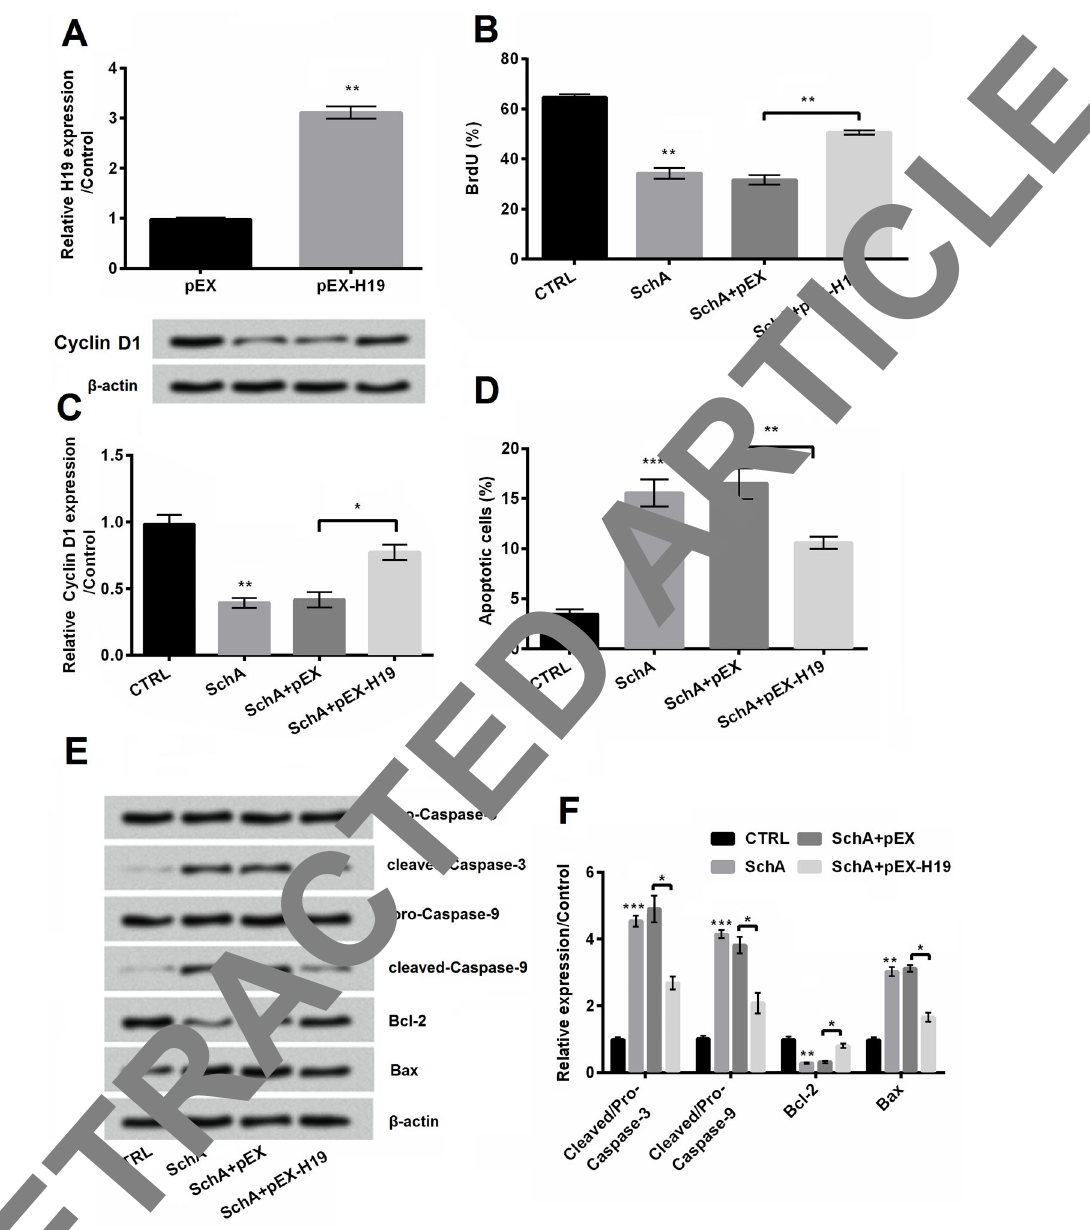
Figure 5. Schizandrin A (SchA) decreased cell proliferation and increased cell apoptosis via down-regulation of H19. A , Overexpression of H19 was established through transfection with pEX-H19 in A375 cells. Cell proliferation ( B ) and ( C ) expression and level of cyclin D1 were analyzed via BrdU, western blot, and quantitatively, respectively. D, Cell apoptosis was analyzed by fl ow cytometry. Cell apoptosis-related proteins were detected by western blot ( E ) and analyzed quantitatively ( F ). b -actin was used as control. All data are reported as means ± SD (n=3). *P o 0.05, **P o 0.01 and ***P o 0.001 compared to control or as indicated (ANOVA and Student ’ s t